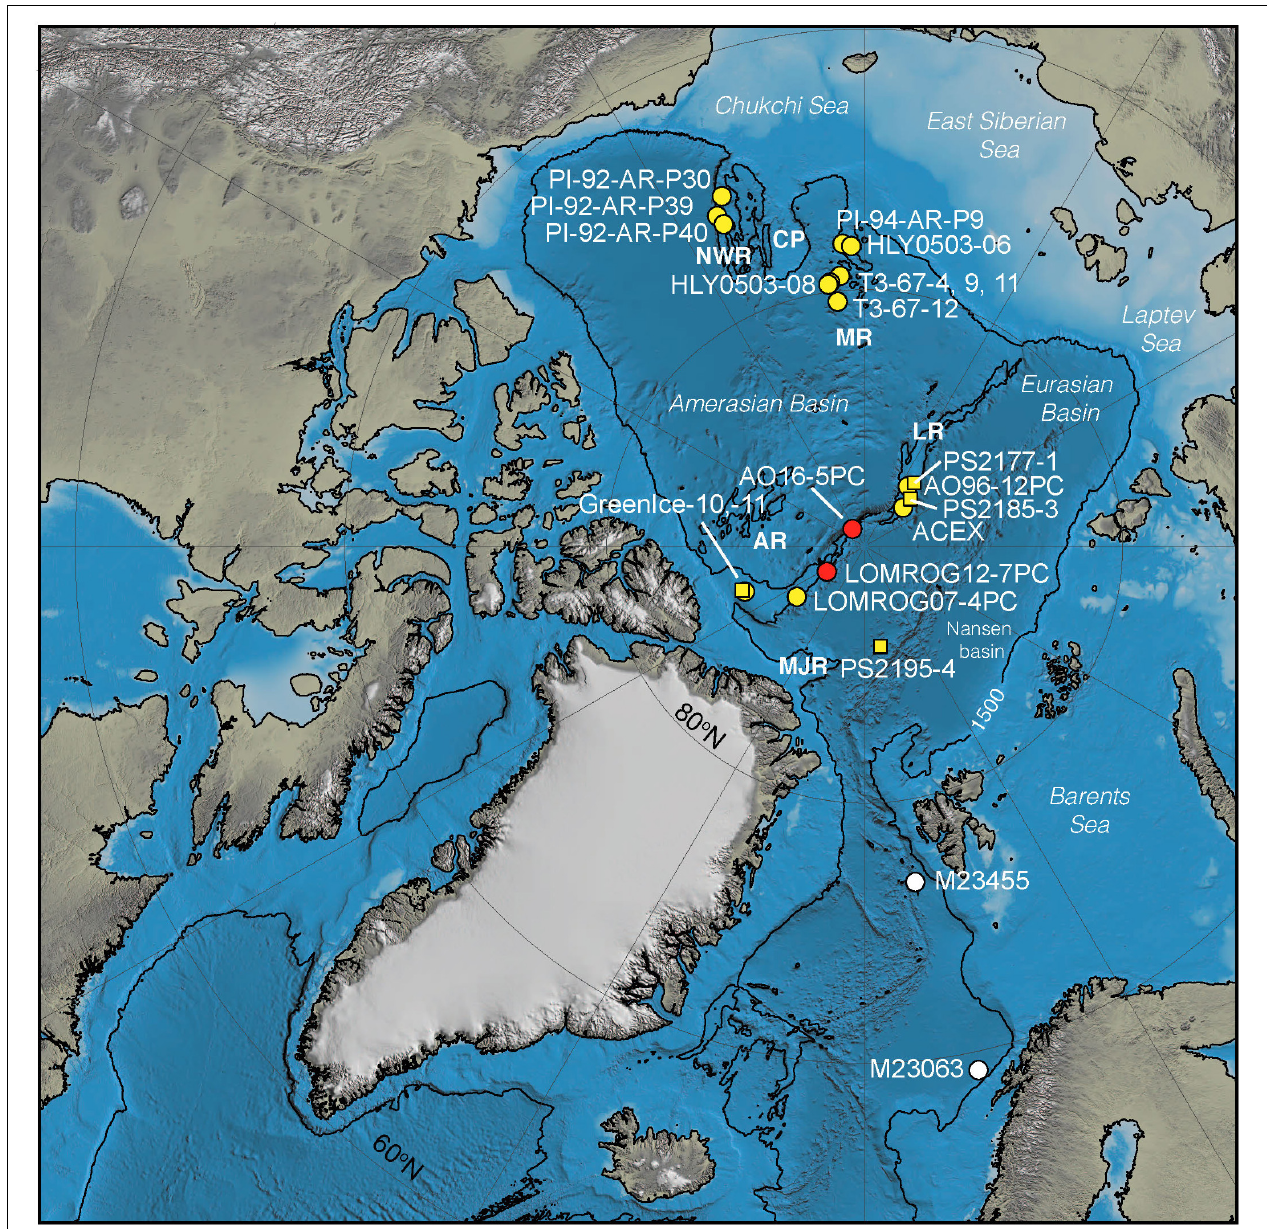
FIGURE 1 | Map of the Arctic Ocean illustrating sites where Turborotalita species have been described in Arctic Pleistocene sediments (yellow circles) and the new records presented in this manuscript (red circles). Yellow squares are box cores where abundances of Turborotalita quinqueloba were described in surface sediments by Nørgaard-Pedersen et al. (2007). References for published records are: P1-92- cores (Cronin et al., 2014), T3- cores (Herman, 1974). HYL0503-08 (Adler et al., 2009), HYL0503-06 (Cronin et al., 2013), ACEX (Eynaud et al., 2009), 96/12-PC (Jakobsson et al., 2001), LOMROG07-4PC (Hanslik, 2011), and GreenIce (Nørgaard-Pedersen et al., 2007). SEM images of representative species of T. quinqueloba from MIS 5 and MIS 11 were acquired from two sites in the Norwegian-Greenland Seas (M23455, M23063) (white circles) and are shown in Figure 7 . AR, Alpha Ridge; LR, Lomonosov Ridge; MR, Mendeleev Ridge; MJR, morris jesup rise; NWR, Northwind